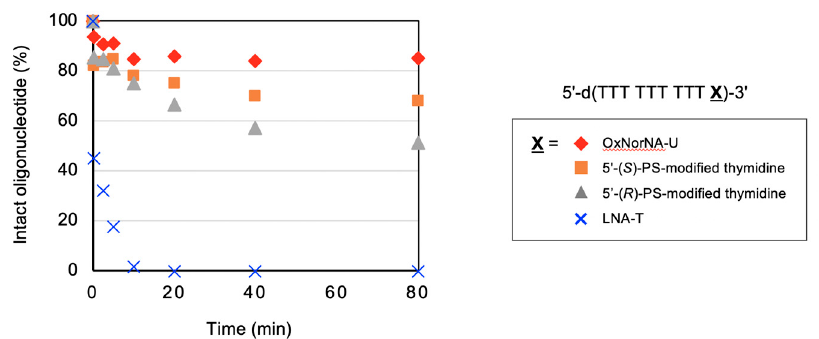
Figure 5. Enzymatic stability of the OxNorNA-modified oligonucleotide. Conditions: 0.133 ug/mL snake venom phosphodiesterase (svPDE), 10 mM MgCl 2 , 50 mM Tris-HCl (pH 8.0), and 2 μ M each oligonucleotide at 37 °C. The sequence of the oligonucleotides used was 5’-d(TTT TTT TTT X )-3’. X = OxNorNA-U (red diamond, ON3 ), X = 5’-( S )-phosphorothioate (PS)-modified thymidine (orange square, ON6 ), X = 5’-( R )-PS-modified thymidine (gray triangle, ON7 ), and X = locked nucleic acid (LNA)-T (blue cross, ON 8 ).